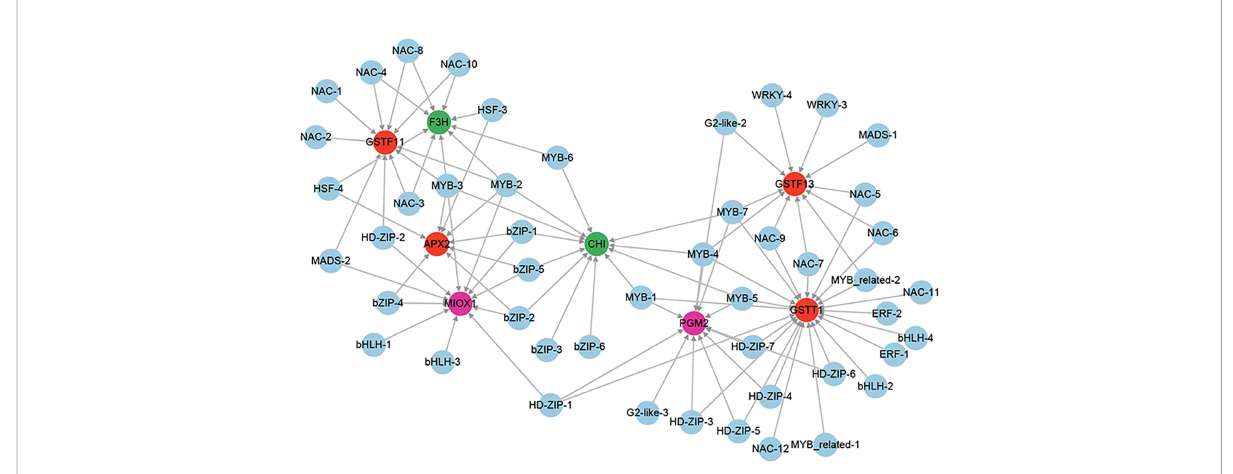
FIGURE 12 The regulatory network of ROS scavenging genes from the core drought-resistant genes in XZSN. Genes labeled by a red circle encode the enzymatic antioxidants. Genes labeled by green and magenta circles represent the genes involved in non-enzymatic antioxidant